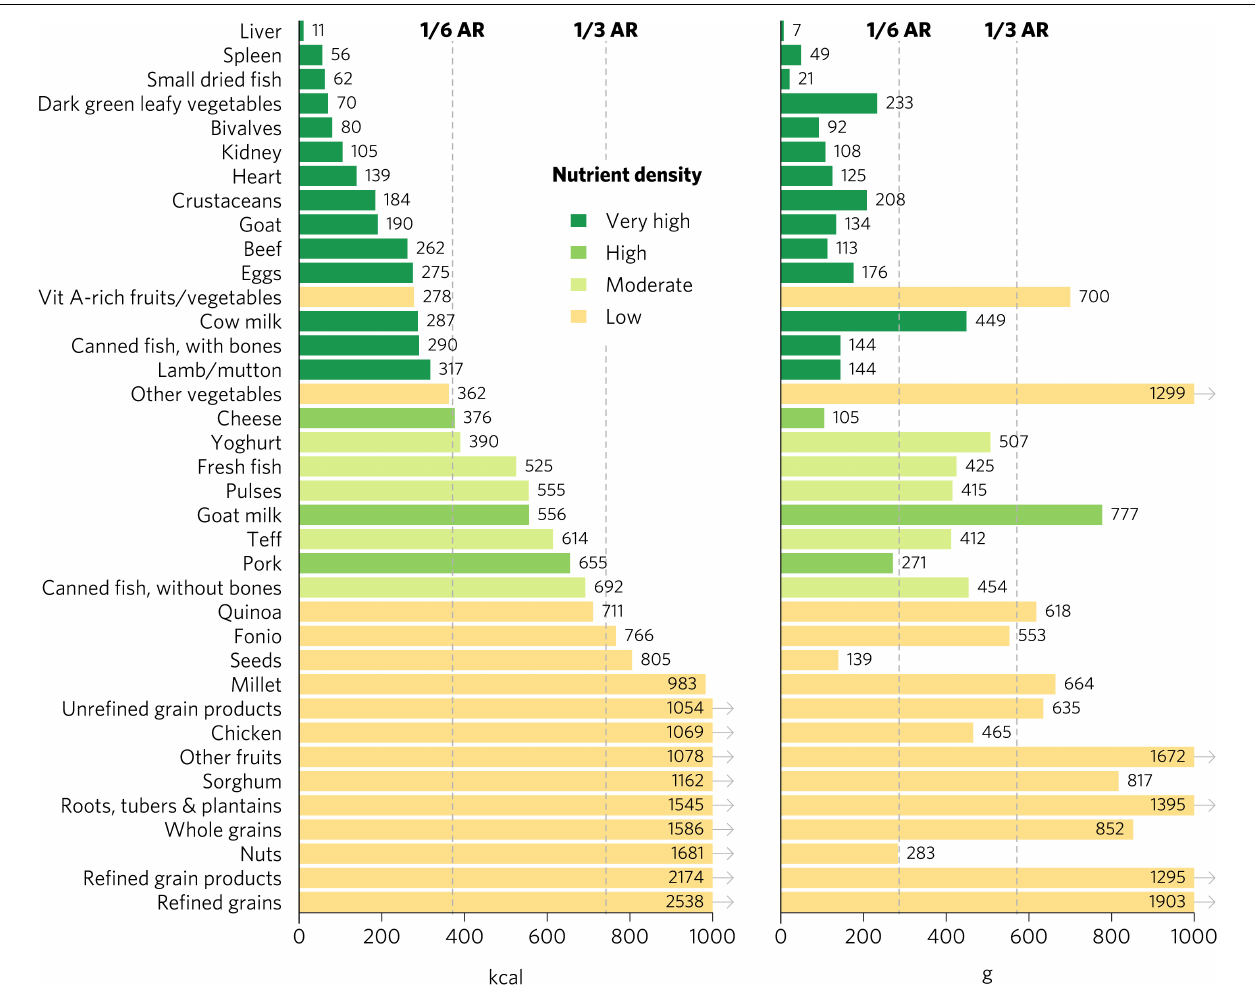
FIGURE 4 | Calories and grams needed to provide an average of one-third of recommended intakes of vitamin A, folate, vitamin B 12 , calcium, iron, and zinc for adults ≥ 25. Each nutrient’s contribution is capped at 100% of recommended intakes. Hypothetical average requirements for mass are based on an energy density of 1.3 kcal/g. AR, average requirement; Vit,